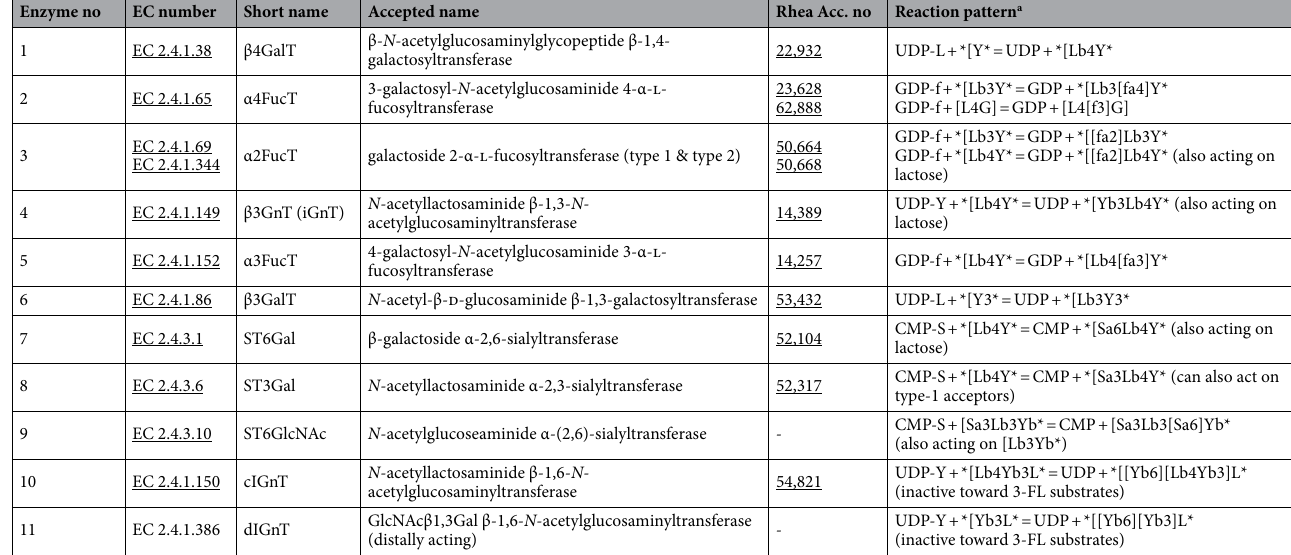
Table 2. Enzymes of the model. Proposed enzymes of HMO biosynthesis and the corresponding reaction definition in Rhea 59 (accession number) as well as Glycologue reaction patterns. a Asterisks act as a wildcard character, to denote an unspecified portion of the oligosaccharide. Symbols and abbreviations used in reaction patterns are those of Table 1, with the following additions: UDP, uridine 5 ′ -diphosphate; GDP, guanosine. 5 ′ -diphosphate; CMP, cytidine 5 ′ -phosphate; CMP-S, CMP- N -acetyl-β-neuraminate; GDP-f ,